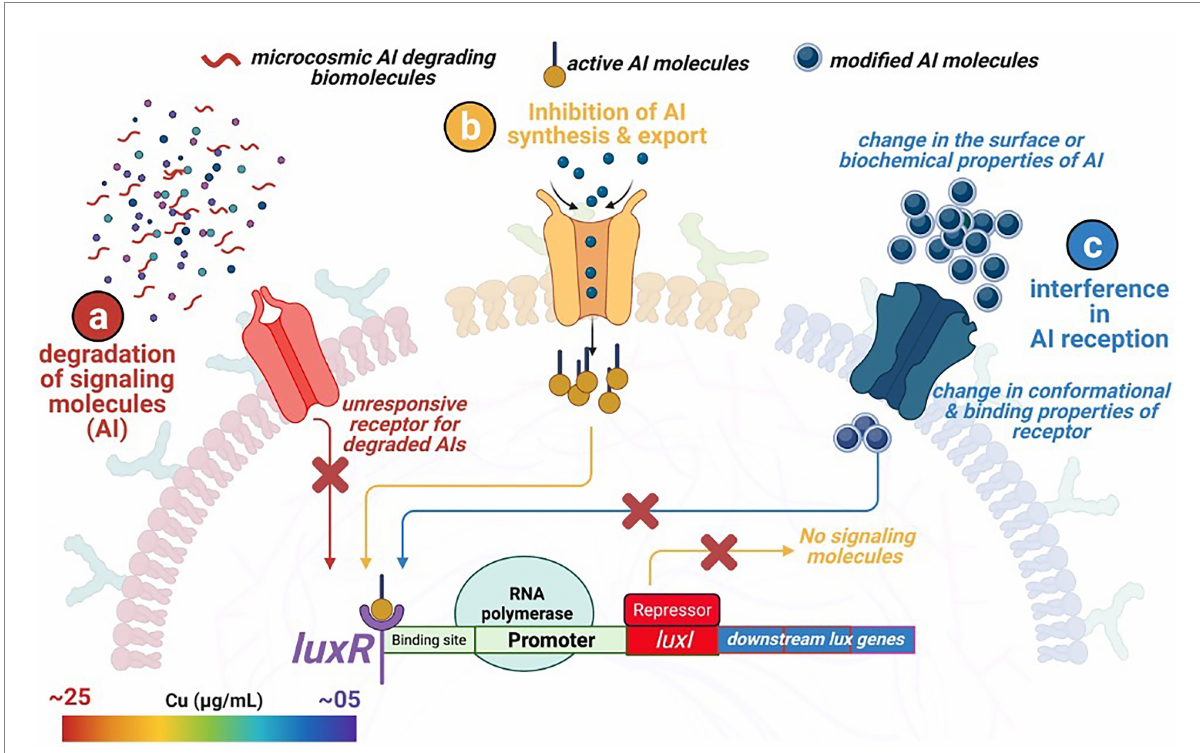
FIGURE 5 Overview of three different quorum quenching mechanisms restricting microbial attachment to external surfaces. (a) degradation of the signaling molecules within the microcosmic environment by competing strains and biomolecules, (b) no synthesis and release of the signaling molecule due to the inhibition of the regulating genes, and (c) change in the surface and conformational properties of the specific membranal receptors recognizing and binding with the signaling